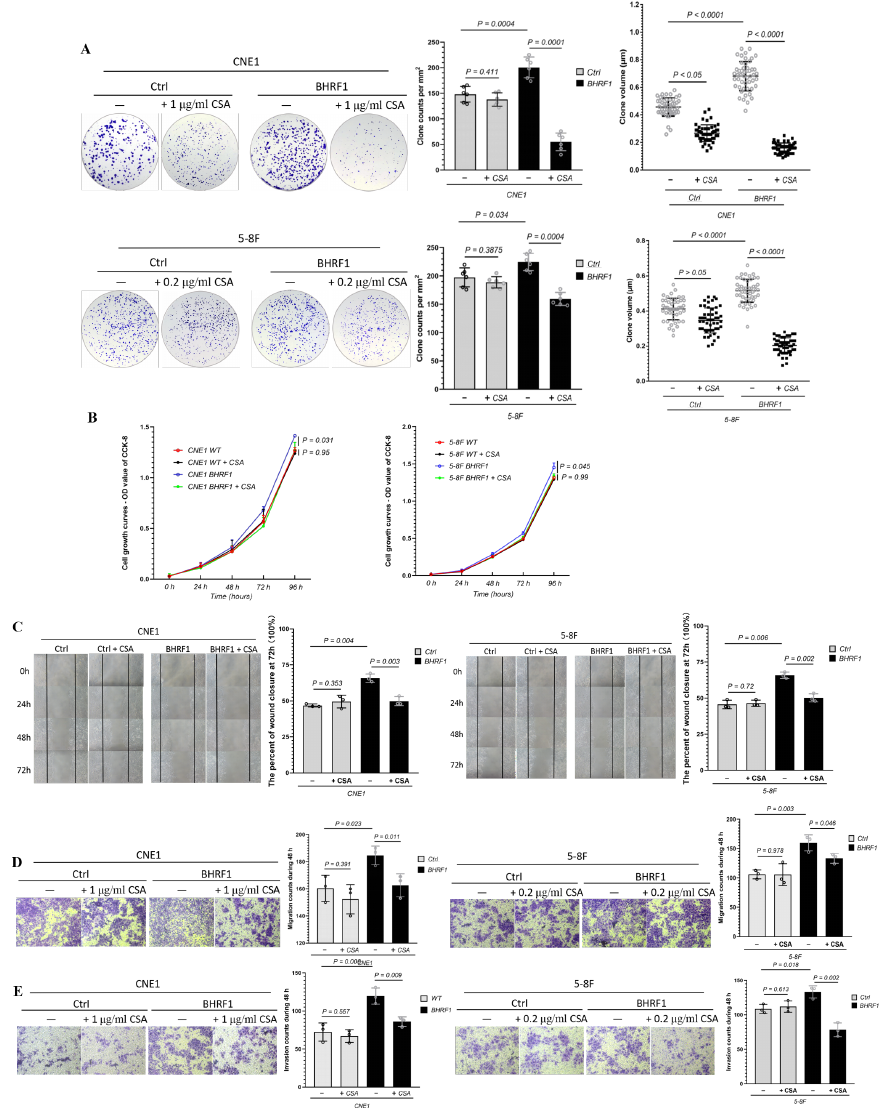
Figure 6. MMPT mediates BHRF1-induced tumorigenesis. ( A ), Colony formation assay of BHRF1 high expression cell lines and the controls with CsA; ( B ), The proliferation of WT and BHRF1 cells with CSA with CCK-8 assay. ( C ), Wound closure assay with CsA; ( D ), Transwell migration assay with CsA and ( E ), Transwell invasion experiment in CNE1, CNE1 BHRF1 and 5-8F, 5-8F BHRF1 cells with CsA. Representative images ( n = 3) are shown and quantitation represents mean ± SE of three independent